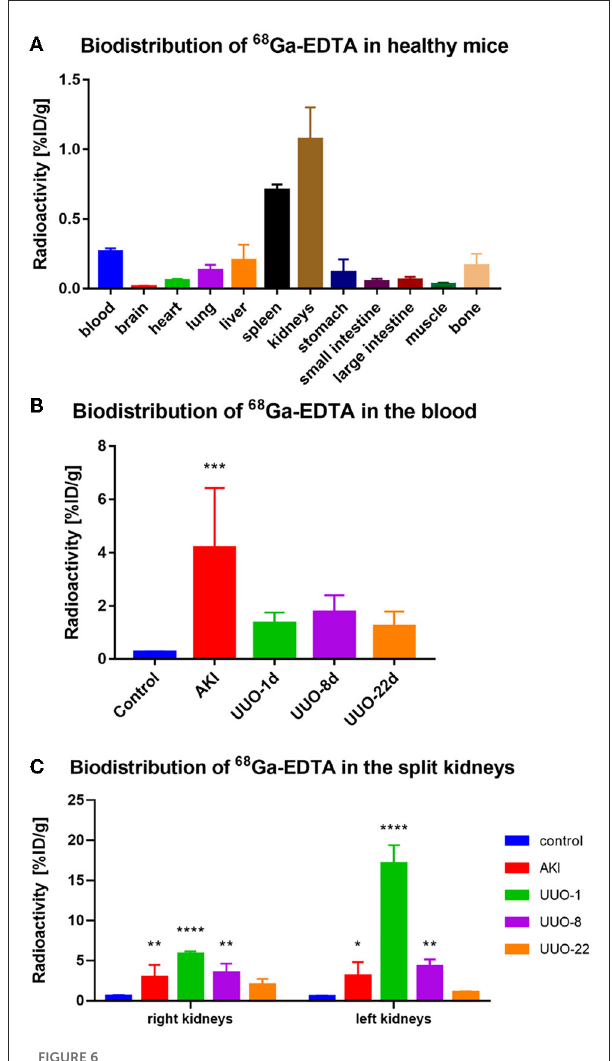
FIGURE6 The biodistribution of 68 Ga-EDTA in vivo . (A) The biodistribution of 68 Ga-EDTA in healthy mice 30-min post-injection. (B) The biodistribution of 68 Ga-EDTA in the blood in healthy mice and other mice with renal dysfunction 30min post-injection. (C) The biodistribution of 68 Ga-EDTA in split kidneys among the different groups. * p < 0.05, ** p < 0.01, *** p < 0.001, **** p <